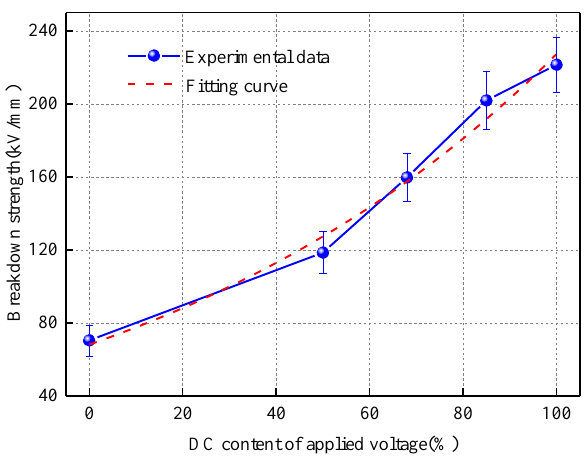
Figure 5. Breakdown strength of pressboard under AC-DC combined voltage.